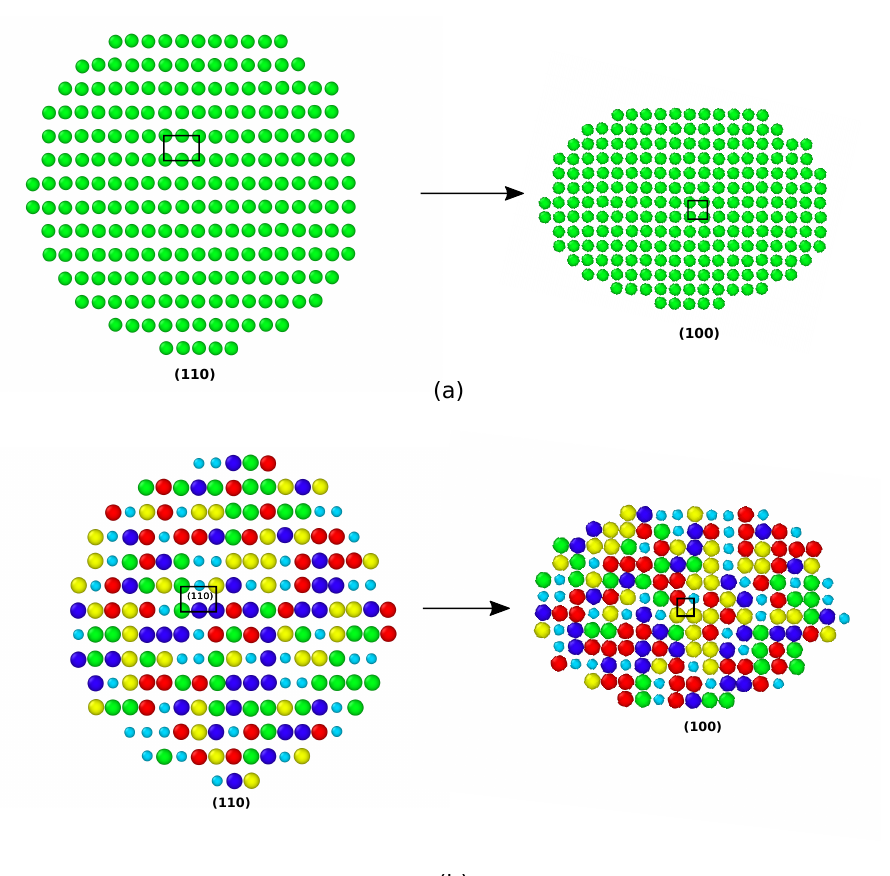
Figure 4. Atomic snapshots of the NW cross-sections at 77 K before and after re-orientation from (110) to (100) phase during tensile deformation of ( a ) silver (Ag) nanowire and ( b ) CoNiFeMnCr HEA nanowire. In CoNiFeMnCr NW, there is no complete re-orientation of the nanowire.